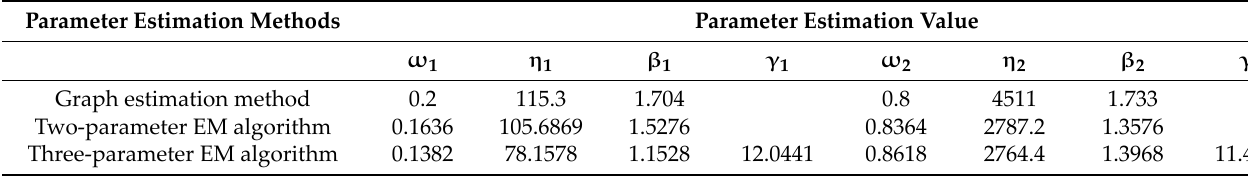
Table 4. Comparison of parameter estimation